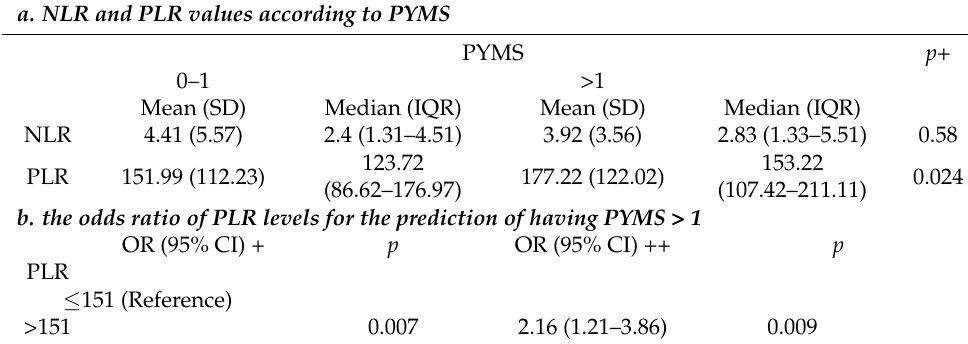
Table 3. (a) NLR and PLR values according to PYMS, (b) the odds ratio of PLR levels for the prediction of having a PYMS > 1.